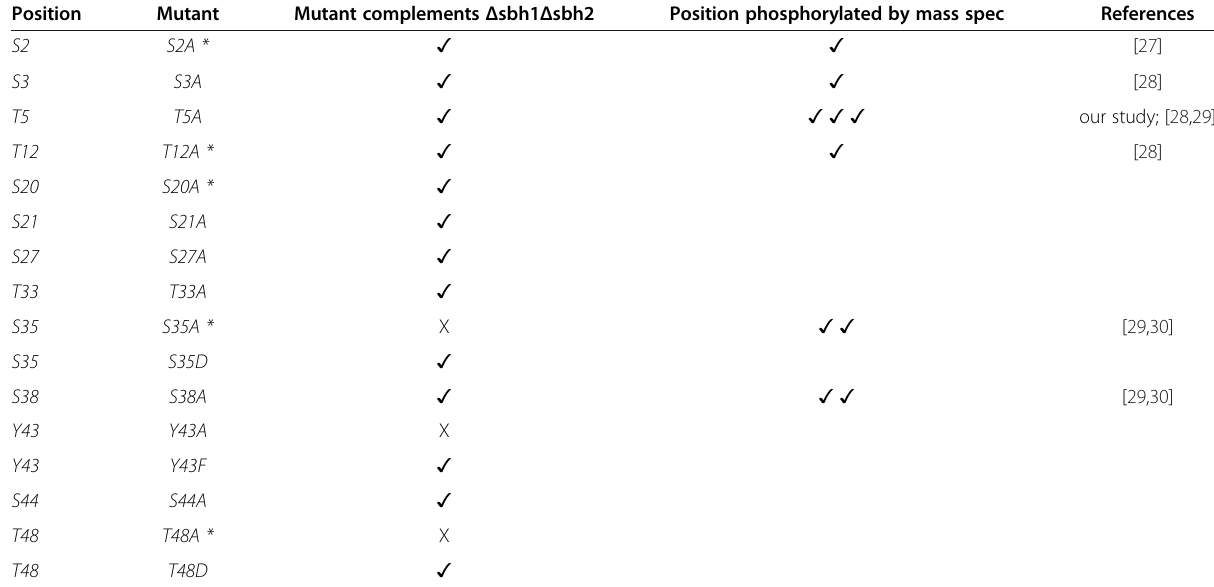
Table 1 Potential & used phosphorylation sites in the cytosolic domain of Sbh1p Position